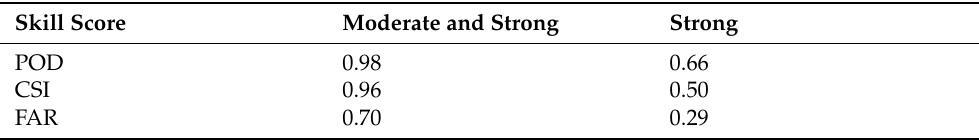
Table 4. Skill scores (POD, FAR, and CSI) for the beta parameter, considering the thresholds for the moderate and strong convection (left) and only strong convection